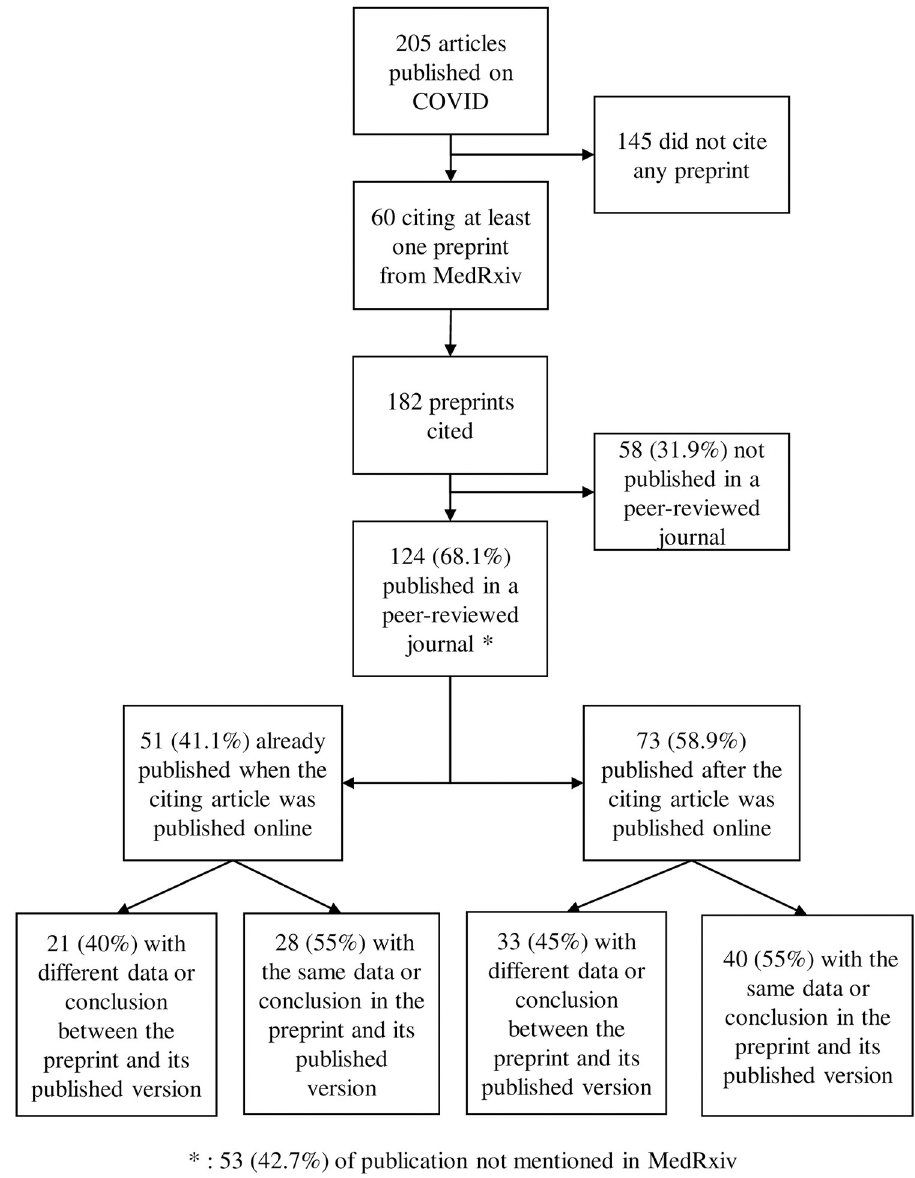
Fig 1. Flow chart of preprint citations and